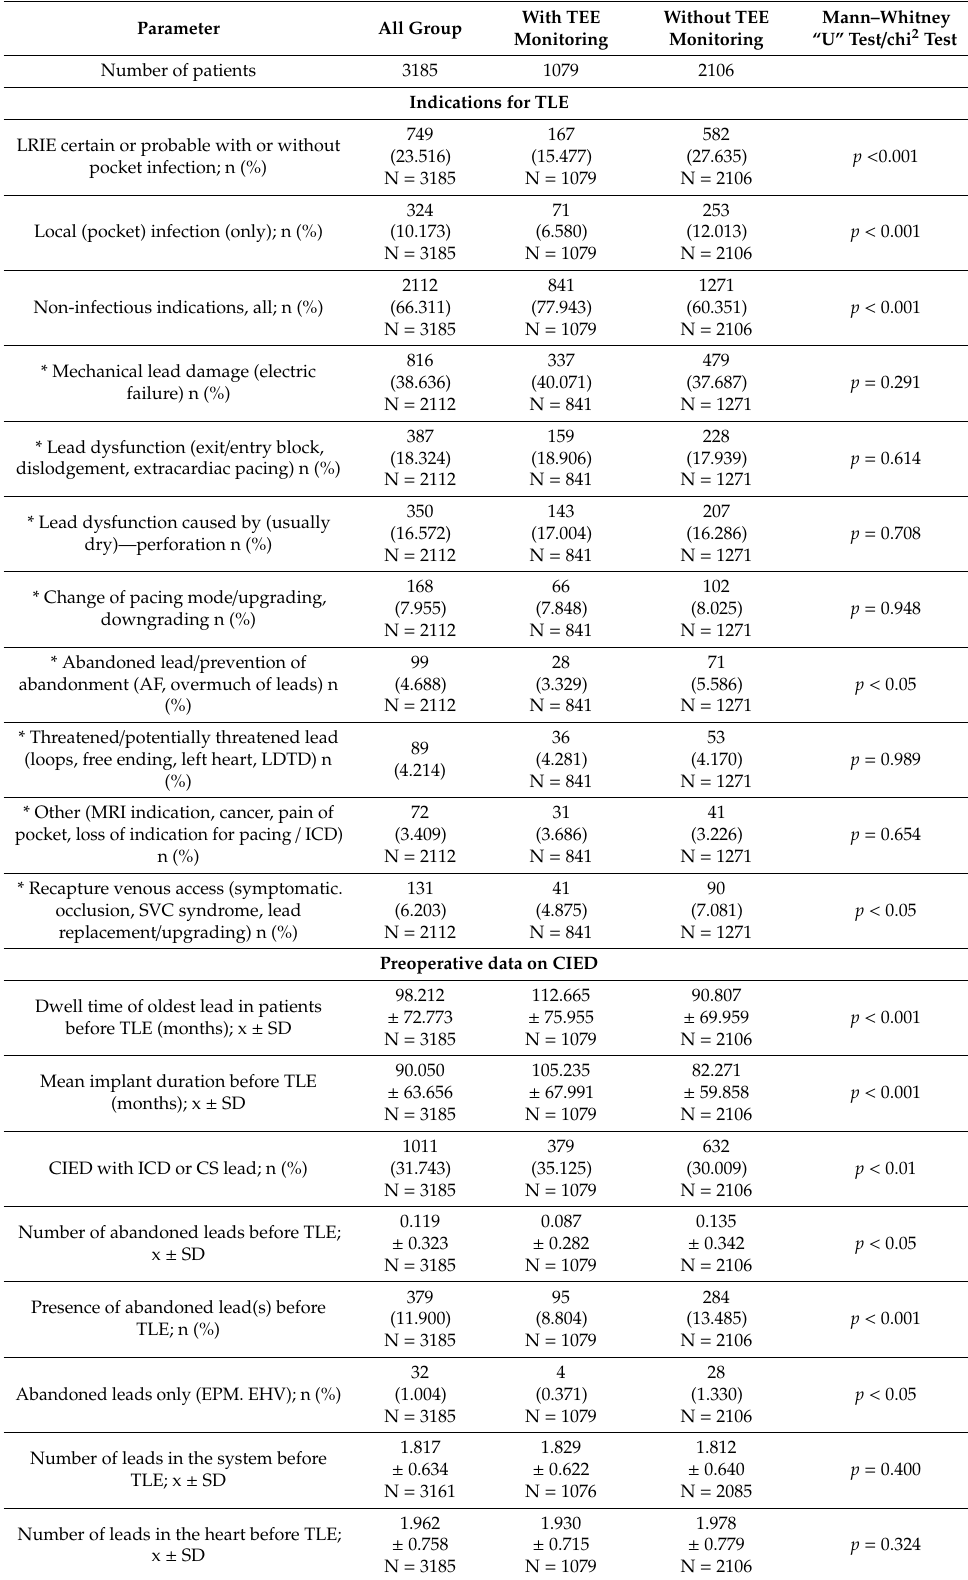
Table 2. Indications for TLE and preoperative data on cardiac implantable electronic devices (CIED). With TEE Without TEE Mann–Whitney Parameter All Group Monitoring Monitoring “U” Test / chi 2 Test Number of patients 3185 1079 2106 Indications for